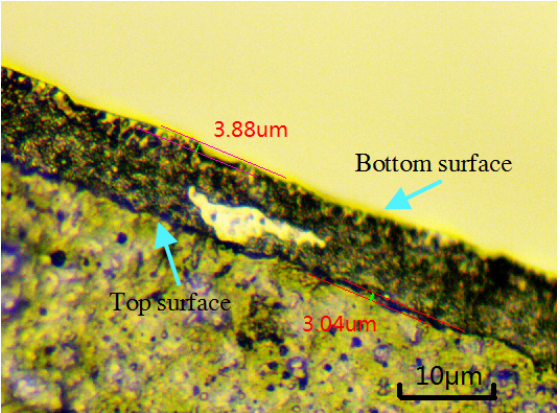
Figure 11. Chipping size test analyzed by microscope.